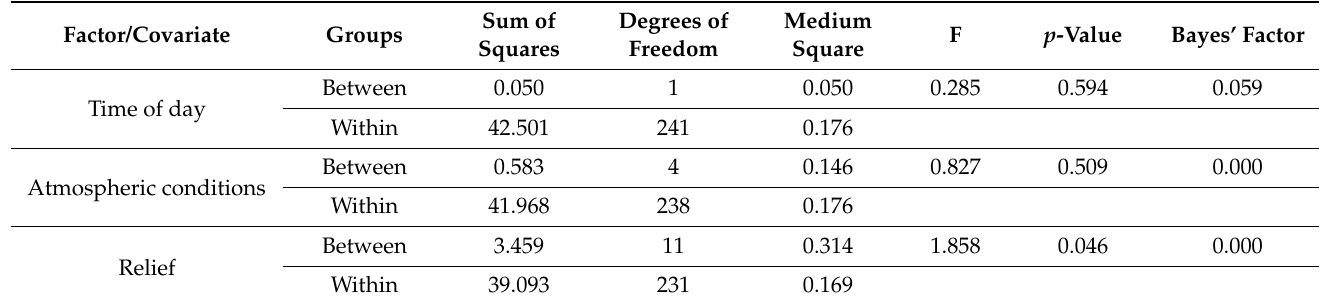
Table 3. Summary of results from Bayesian ANOVA to detect differences in mean probability of success in prey escape across environment-related factors and